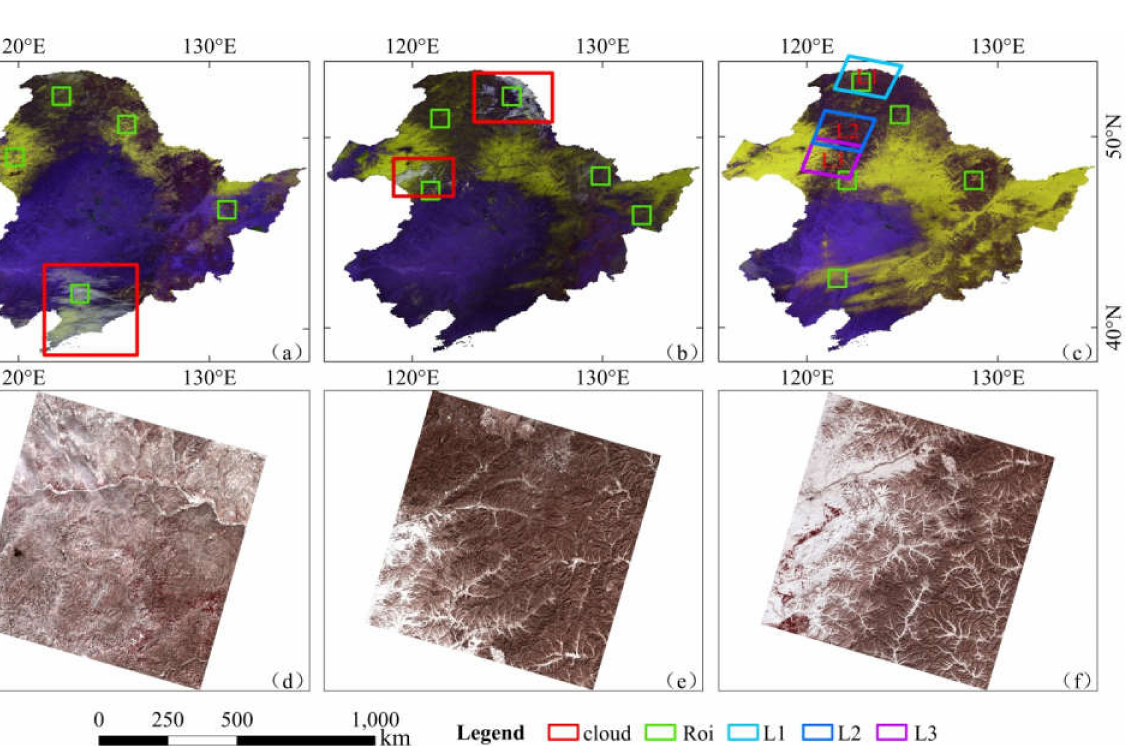
Figure 8. False-color reflectance images of MODIS combined with bands NIR/Green/SWIR and of OLI combined with bands NIR/Red/Green. ( a ) MODIS acquired on 12 February 2019, ( b ) MODIS acquired on 22 March 2018, ( c ) MODIS acquired on 16 March 2018, ( d ) OLI_L1 acquired on 16 March 2018, ( e ) OLI_L2 acquired on 16 March, 2018, ( f ) OLI_L3 acquired on 16 March 2018. Figure 10a–c are NDSI_var images, in which the high NDSI_var values roughly correspond to the cloud pixels in Figure 8a–c. After performing the cloud–snow identifica- tion experiment on NDSI_var images, the new NDSI_ Snow_Cover layers are shown in Figure 11a–c; the red pixels are new cloud masks. The new cloud distribution appeared